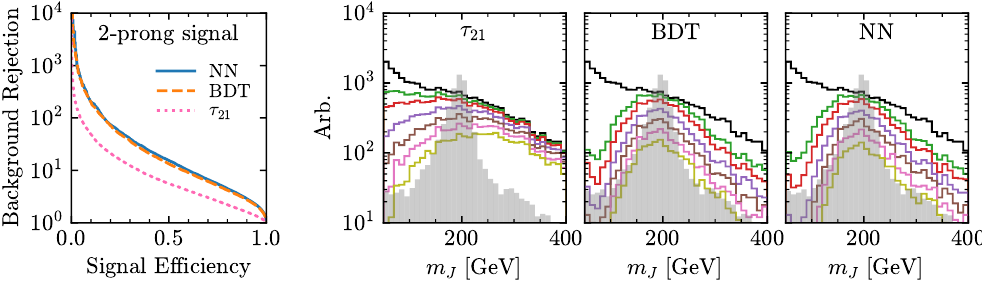
Figure 4: The left panel shows the ROC curves for three traditional methods, two based on machine learning, to classify a 2-prong signal jet from a QCD jet. The machine learning based methods achieve an area significantly higher than the single variable τ based classifier. The right panels show the background only distributions 21 for successively tighter cuts in the solid lines: signal efficiency of 1.0 (black), 0.95 (green), 0.9 (red), 0.8 (purple), 0.7 (brown), 0.6 (pink) and 0.5 (yellow). The signal with no cuts is shown in the filled-in, grey distribution. The only background events which pass the cuts end up having masses similar to that of the signal, even though the machine learning models do not have access to the